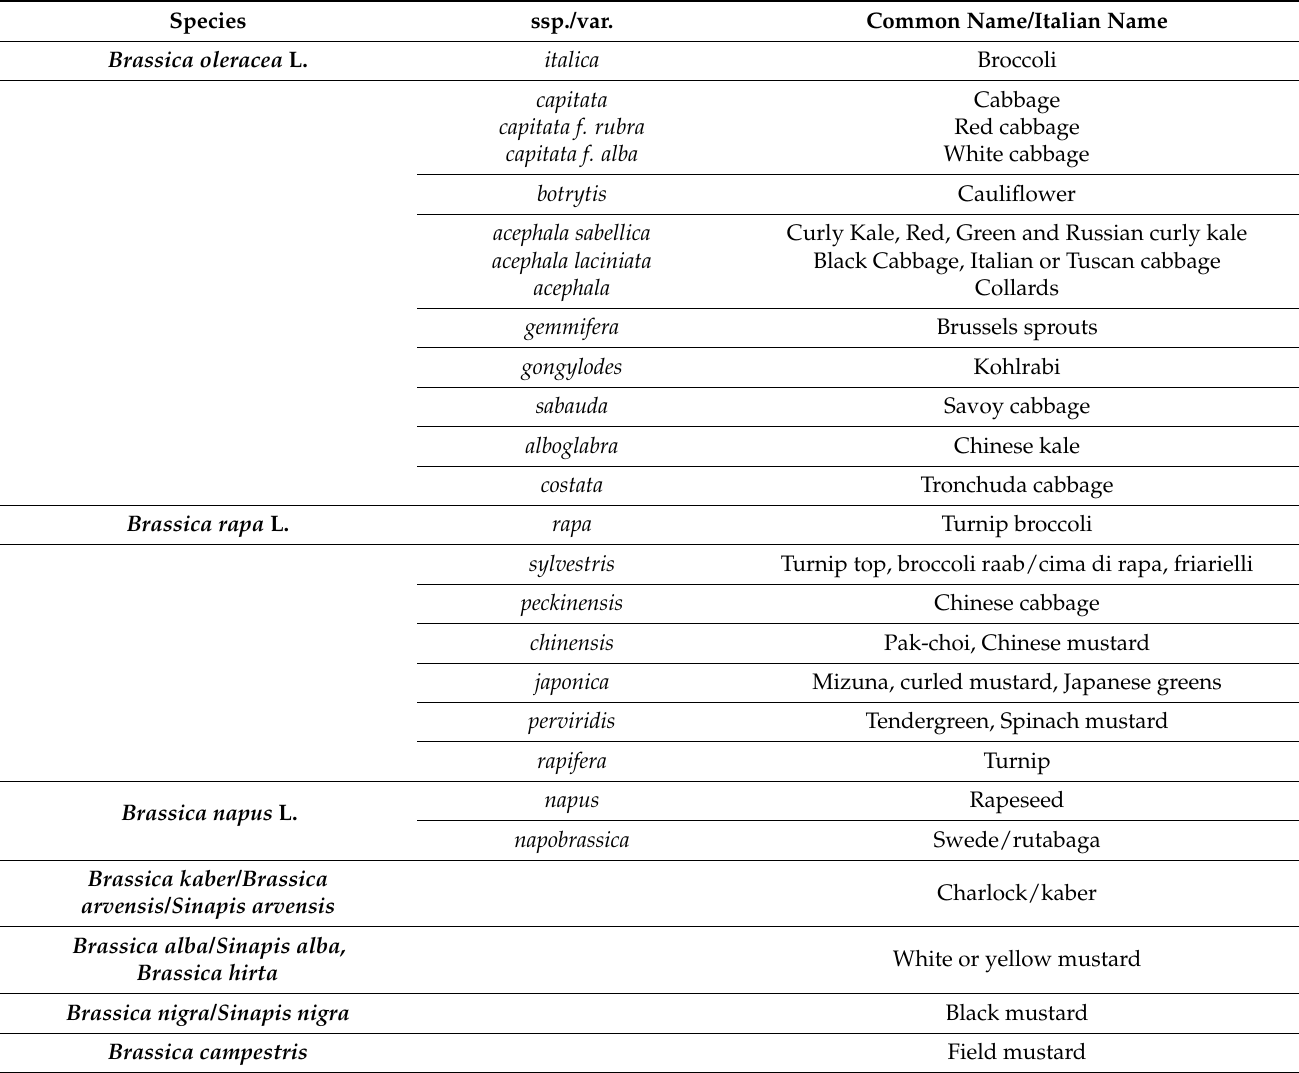
Table 1. Main species, subspecies (ssp.) and varieties (var.) of Brassicaceae family crops consumed as food vegetable in the world